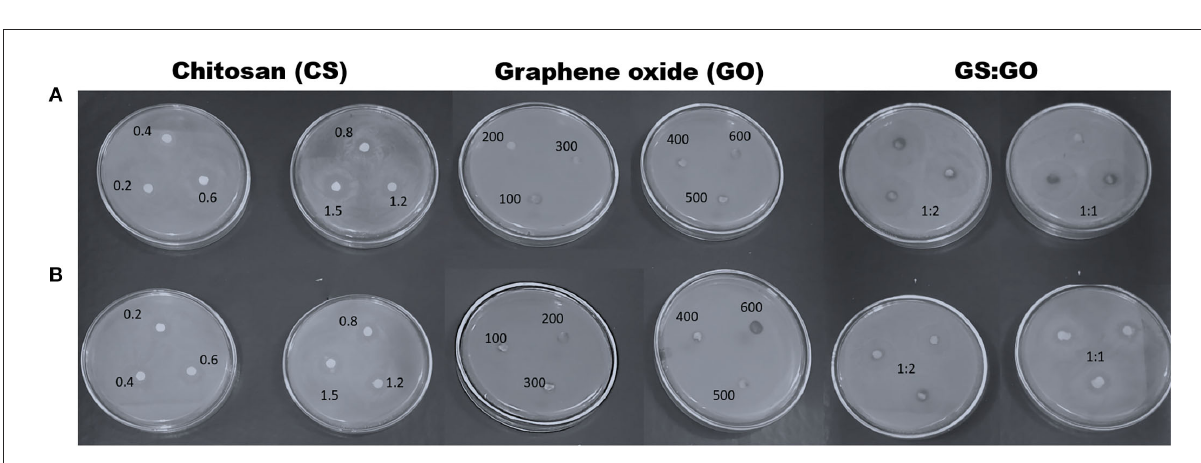
FIGURE4 Inhibition zone diameters of chitosan, graphene oxide, and different combinations (1:1 and 1:2) against Bacillus cereus , BC (A) , and Pseudomonas aeruginosa , PAO1 (B)